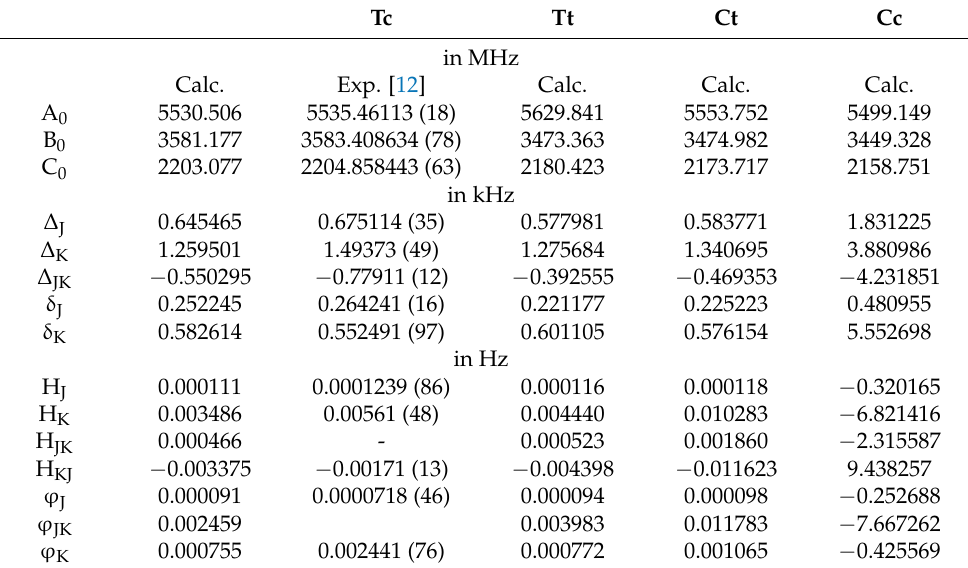
Table 4. Ground vibrational state rotational constants (in MHz) and centrifugal distortion constants corresponding to the asymmetrically reduced Hamiltonian parameters (I r representation) a . Tc Tt Ct Cc in MHz Calc. Exp. [12]